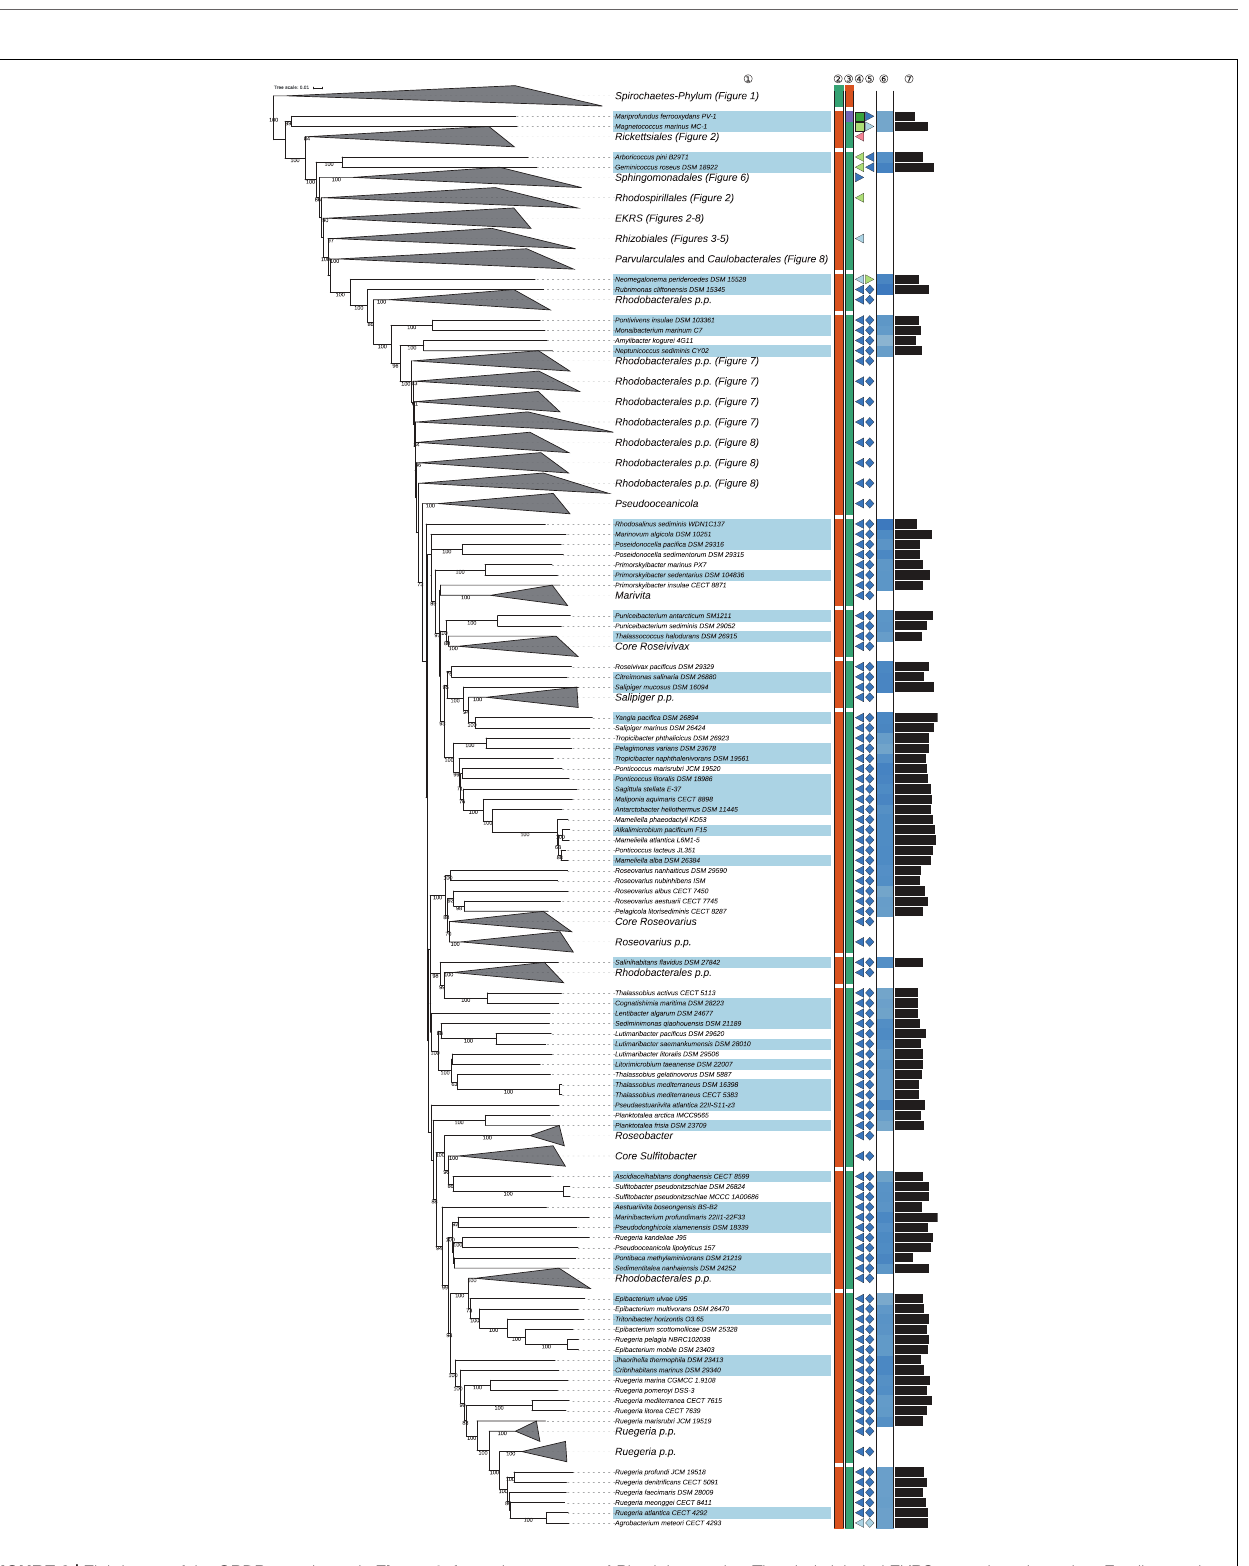
Frontiers in Microbiology |